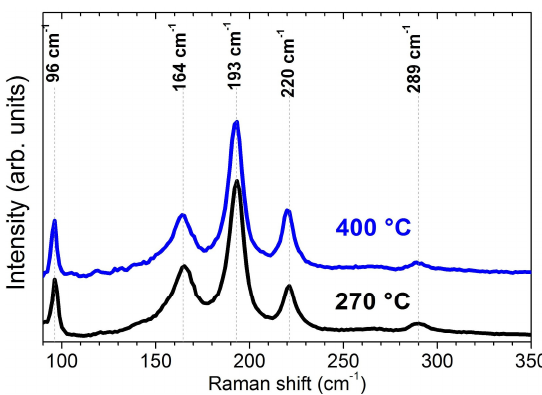
Figure 3. Raman spectra of SnS thin films deposited at 270 °C (black line) and at 400 °C (blue line).